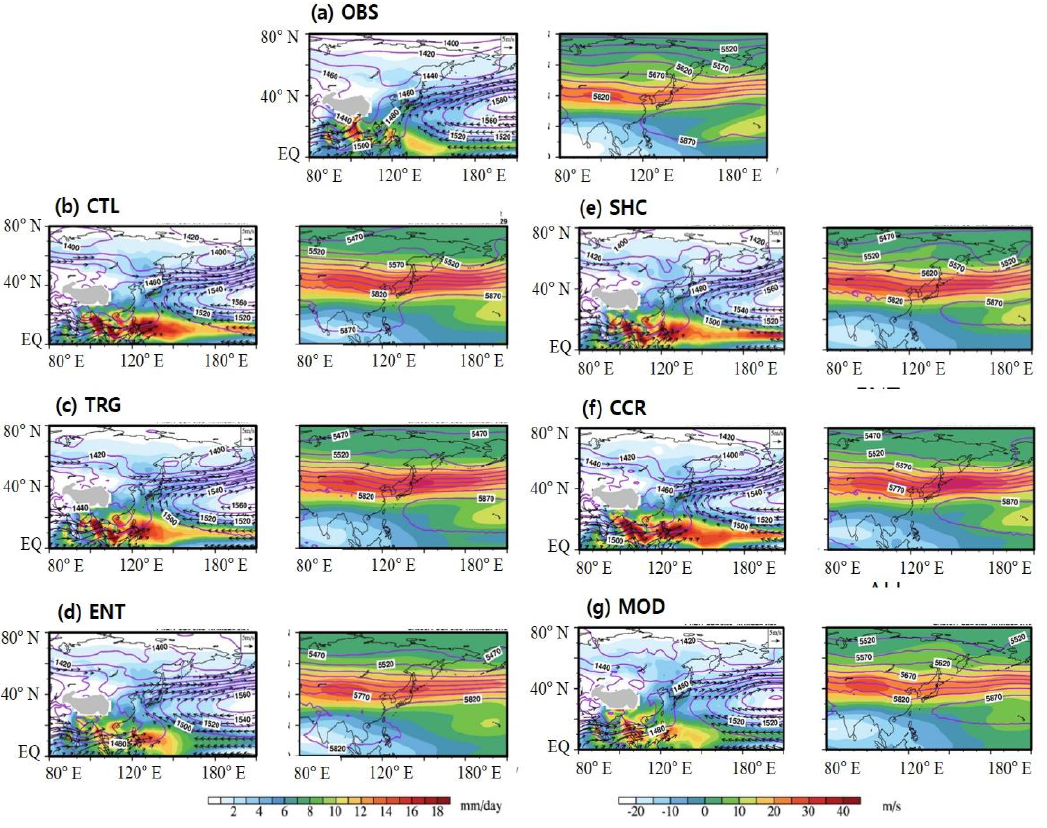
Figure 5. JJA large-scale climatology from: ( a ) observation; and ( b – g ) models. Left panels represent precipitation (shading, mm/day), geopotential height (contours, m) and winds (vectors, m/s) at 850 hPa. Right panels show zonal wind at 200 hPa (shading, m/s) and 500-hPa geopotential height (contours, m).